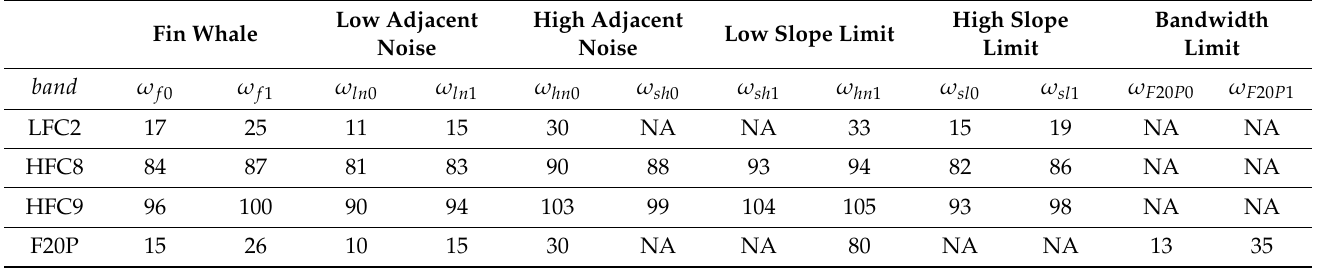
Table 1. Frequency limits for PSD operations per band. All frequency values in